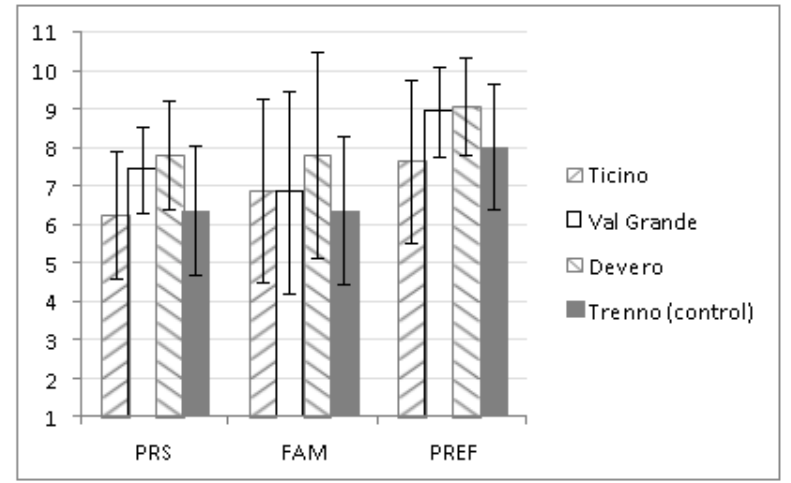
Figure 3. Figure 3. Cont.